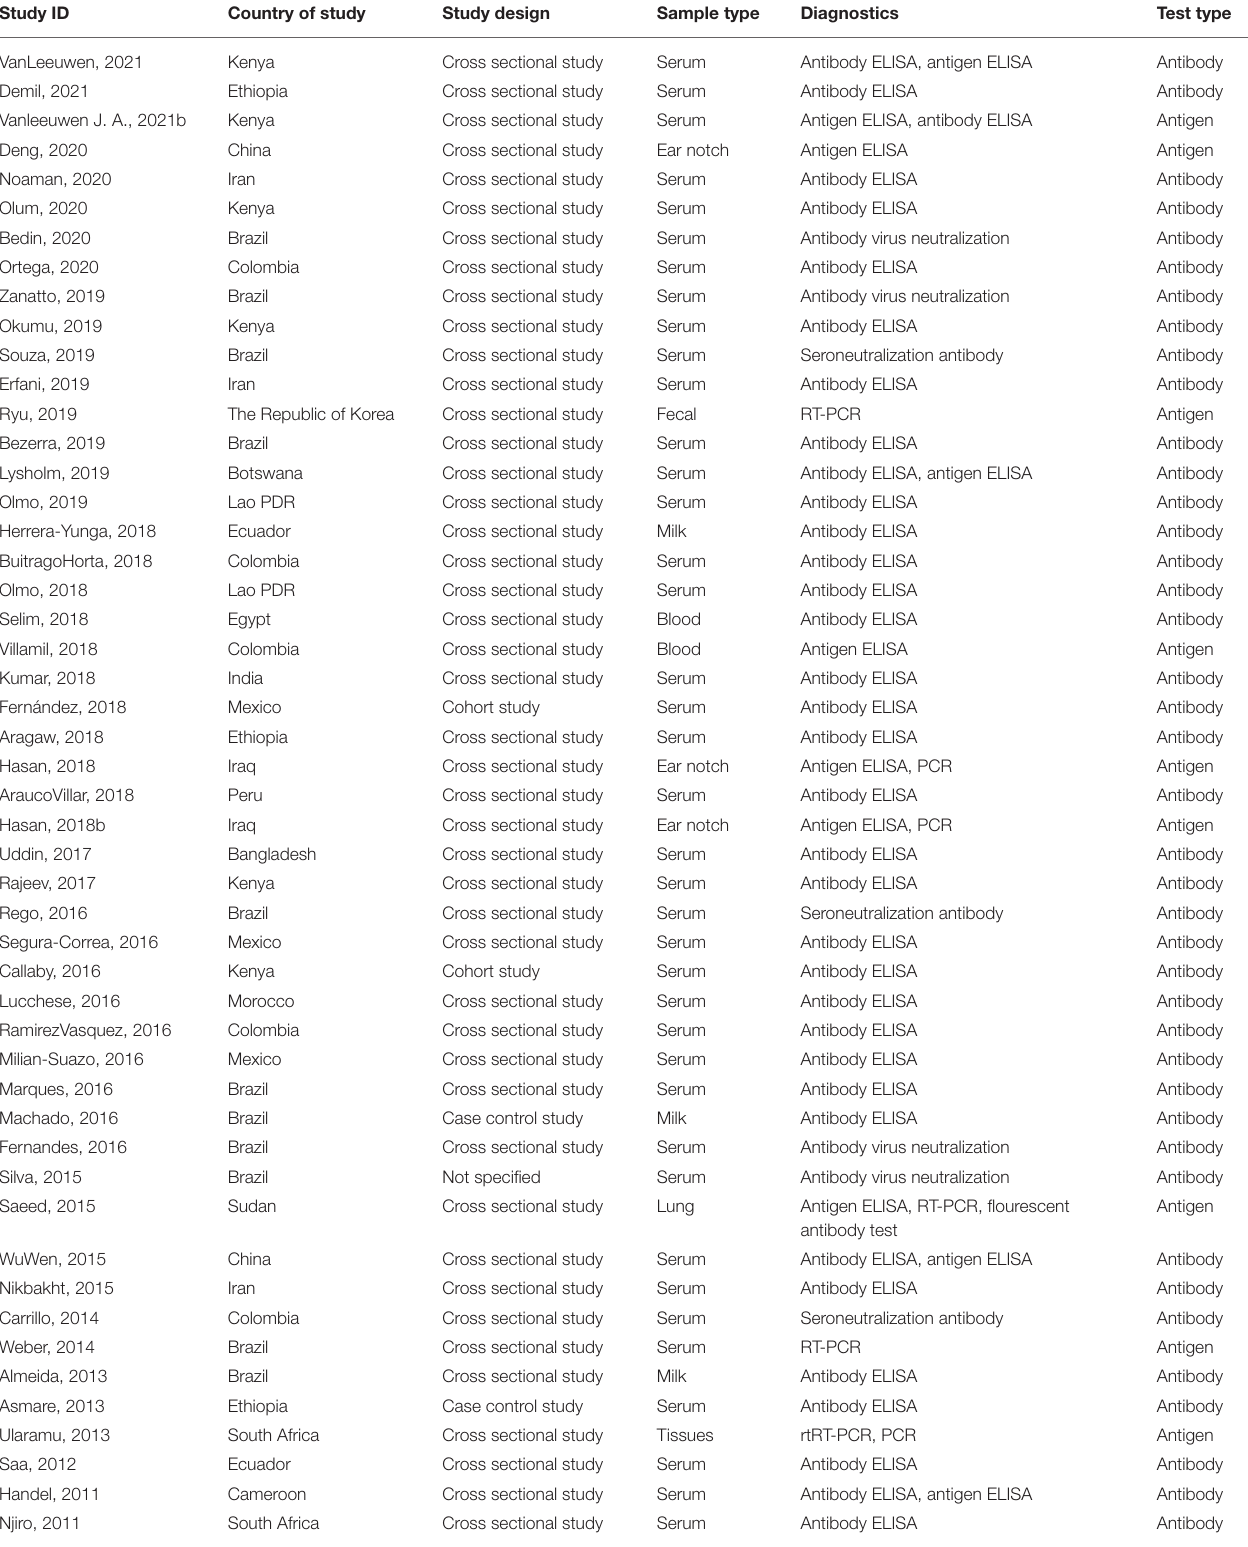
TABLE 1 | Final list of studies included in the systematic review of BVDV in LMICS ordered by year of